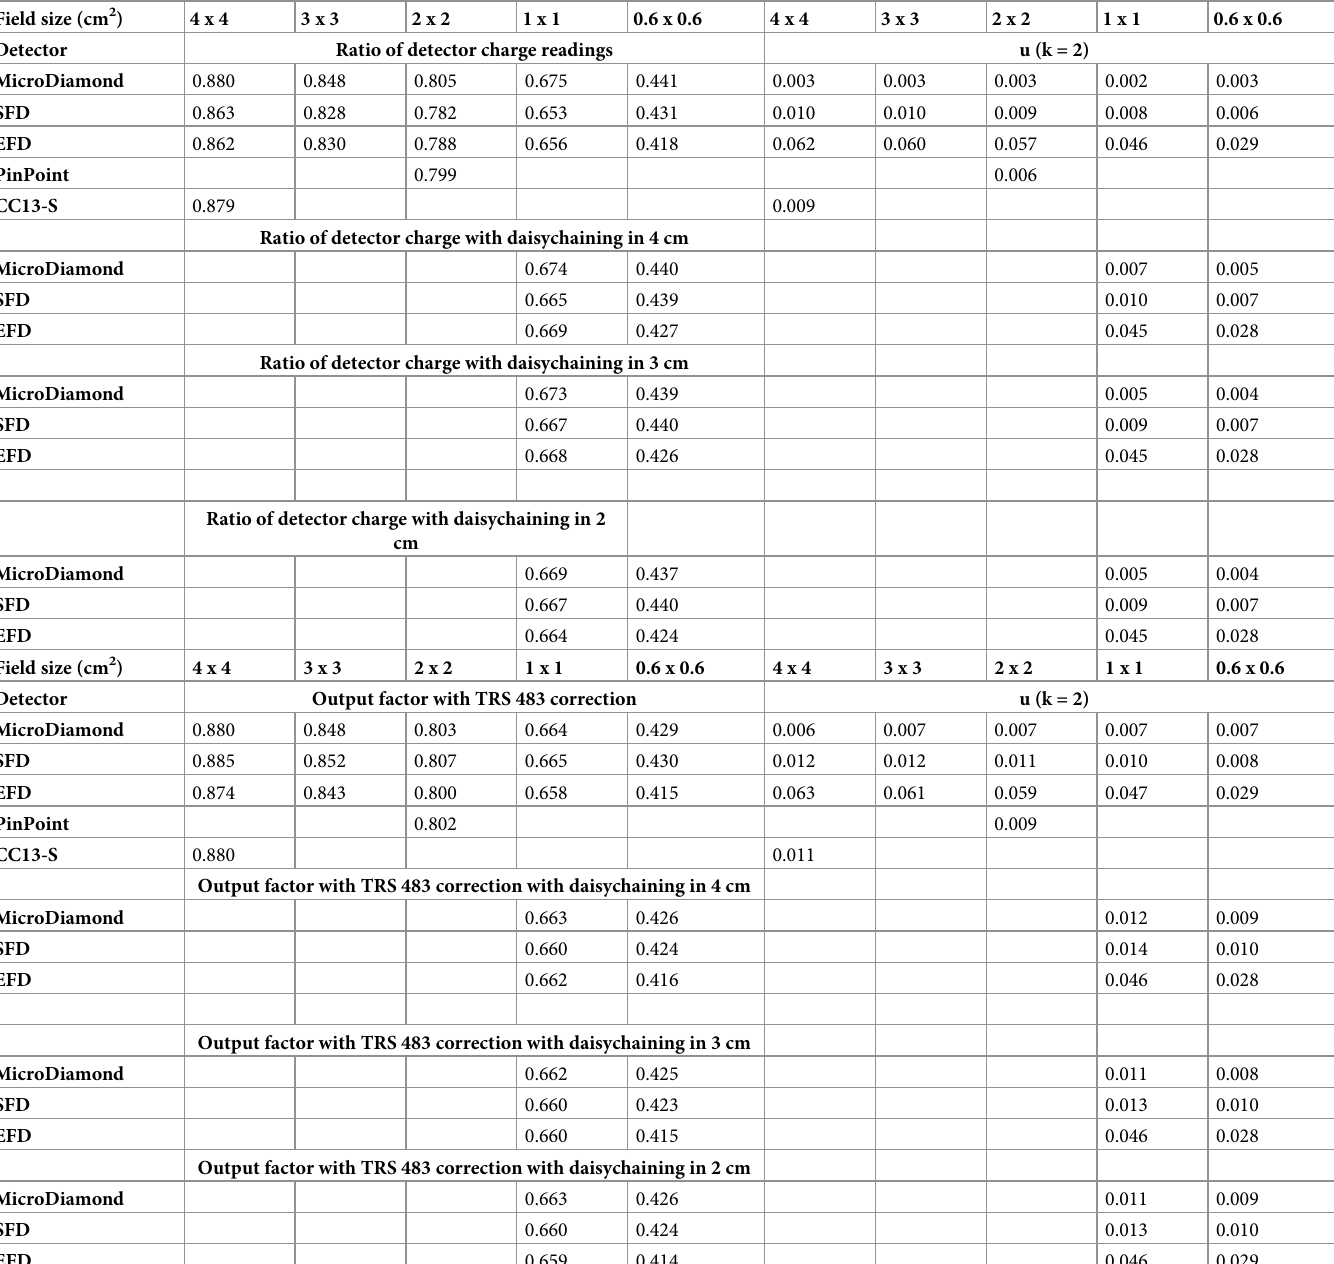
Table 4. Ratio of detector readings for different detectors depending on the field size for 6 MV beams (top of the table) and output factors with TRS 483 correction (bottom of the